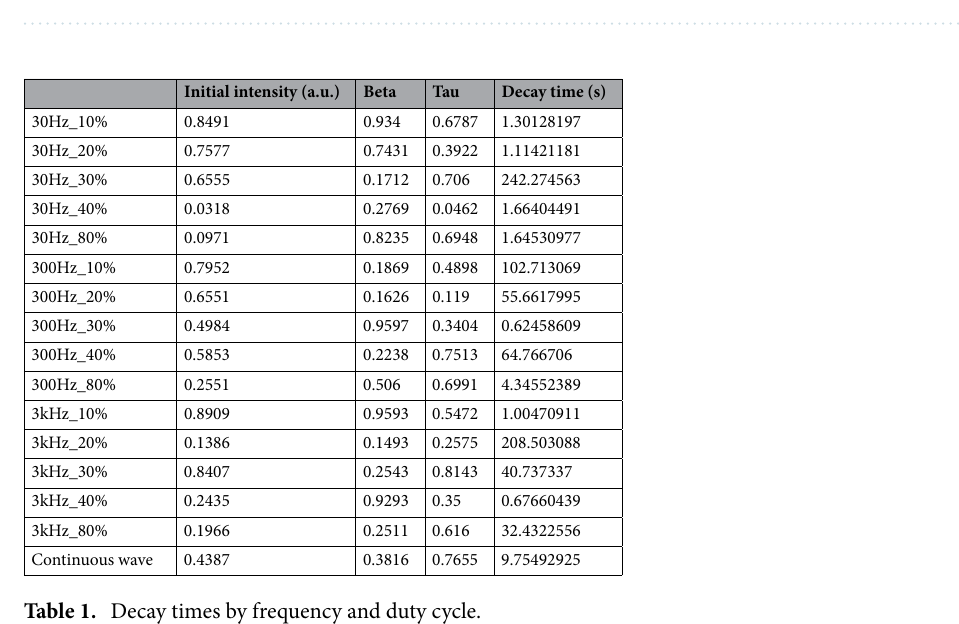
Figure 1. Schematics of the PBM device and experimental time schedule. ( A ) The PBM device for this study. The light source is placed in a 37 °C incubator to block light other than the light source. The 950 nm LEDs are placed at 10 mm intervals, and a disperser is used to produce uniform irradiation. The transparent acrylic cell culture plate is placed 50 mm above the LEDs. ( B ) Timelines of the experiments. All frozen cells were thawed in a 37 °C water bath for 2 min. All measurements, except those of apoptosis, were performed immediately after cells were irradiated with 950 nm NIR or treated with N-acetylcysteine (NAC). Apoptosis of cells was measured after 6 h.